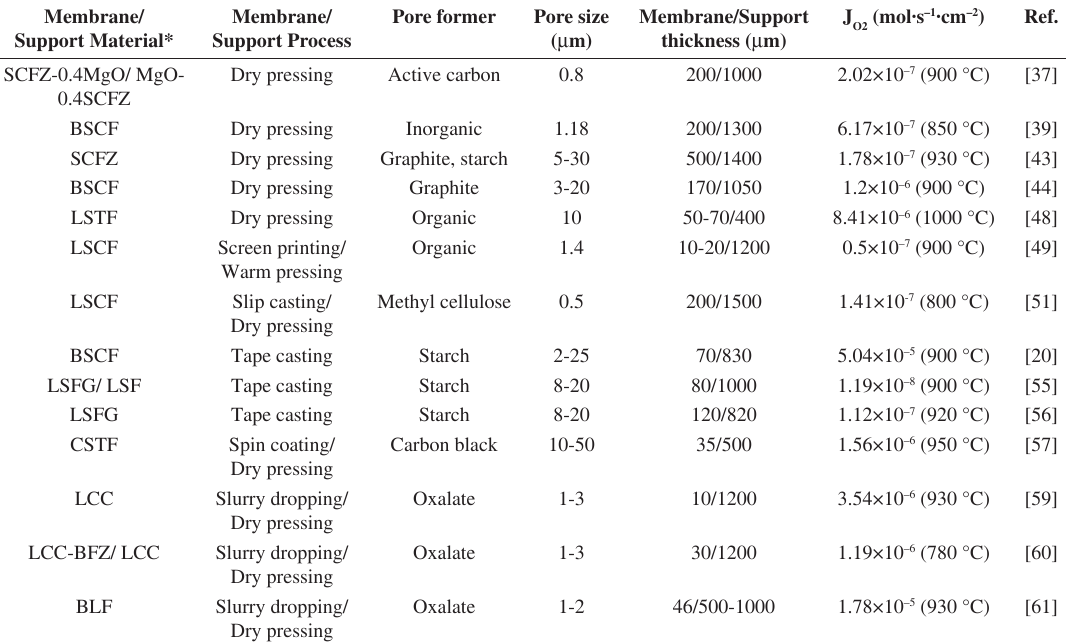
Table 1. MIEC membranes on porous substrates: materials and properties. Membrane/ Membrane/ Support Material* Support